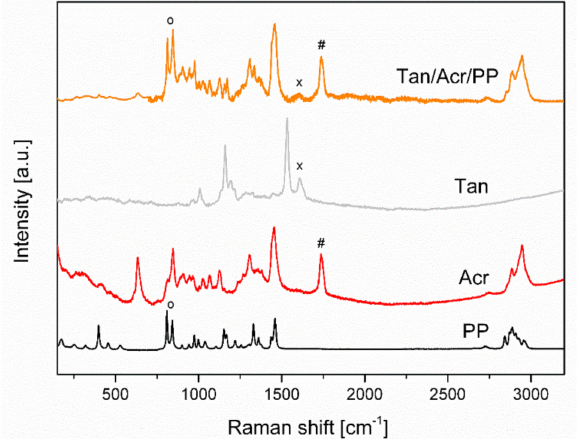
Figure 5. Raman spectra of PP mat modified with Acronal ® 500 D and Tansy flowers extract and spectra of all constituents. O —peak of CH 2 wagging, CCH 3 stretching (809 cm − 1 ) and CC backbone stretching, CH 2 wagging, CCH 3 stretching and CH 3 bending (847 cm − 1 ) of PP, #—peak of the C=O stretching of Acr, x—region of the N-H and O-H bending vibrations. Samples acquisition parameters: power/integration time: PP: 1%/10 s; Acr: 1%/300 s; Tan: 1%/10 s; Tan/Acr/PP: 1%/120 s.